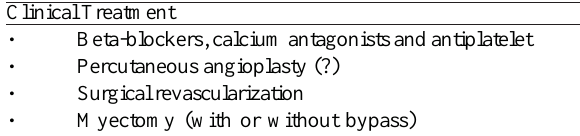
Table 2. Major therapeutic